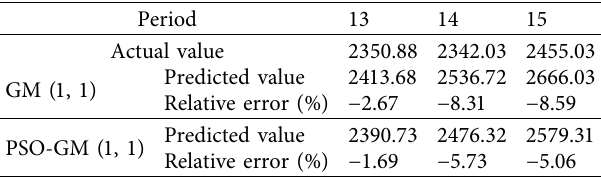
Table 5: Comparison of actual and predicted values of